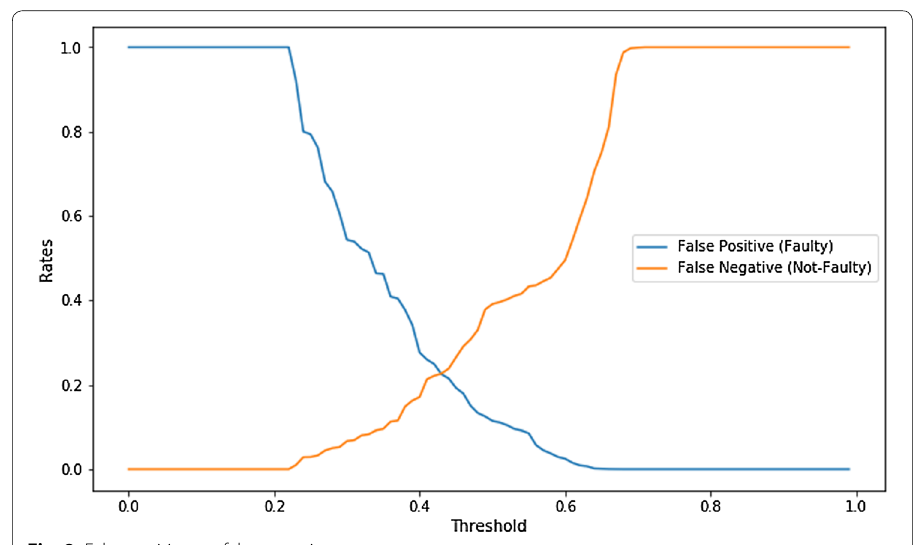
Fig. 8 False positives vs false